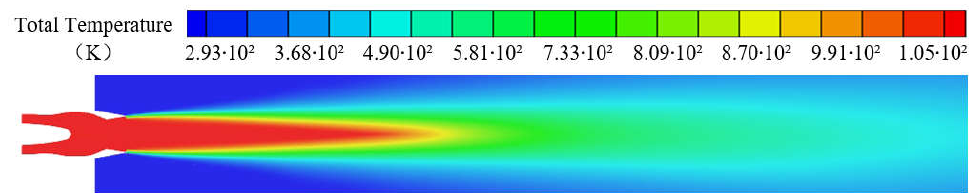
Figure 5. Cloud chart of Mach. Figure 6. Cloud chart of total pressure. Considering the cloud charts obtained by the calculation, the main heat source of the aero-engine tail nozzle is the high-temperature tail flame ejected from the tail nozzle. Con- currently, according to the Mach number and the total pressure cloud chart, the gas flow gradually accelerates in the convergent section and reaches the speed of sound at the throat position. Owing to the three-dimensional flow pipeline effect, the sonic surface is a circular arc surface that protrudes in the rearward direction. Then, the gas flow continues to accelerate to supersonic speed in the expansion section, inducing the expansion wave system, and the expansion waves continue to reflect and intersect in the tube. When the gas flow reaches the nozzle position, it is in a state of slight overexpansion, which induces a compression wave system and forms a local high-Mach-number area. The maximum Mach reaches approximately 1.77. The local high-Mach-number area also significantly impacts the intensity of infrared radiation. The mass fraction field distribution of CO 2 and H 2 O was considered for analy- sis, and the concentration field distribution of components was intercepted at multiple distance interfaces behind the nozzle. The distribution trend of the mass fraction field of the remaining infrared active components is similar, and thus the trend was not analyzed. The distribution of CO 2 components is consistent with that of temperature as shown in